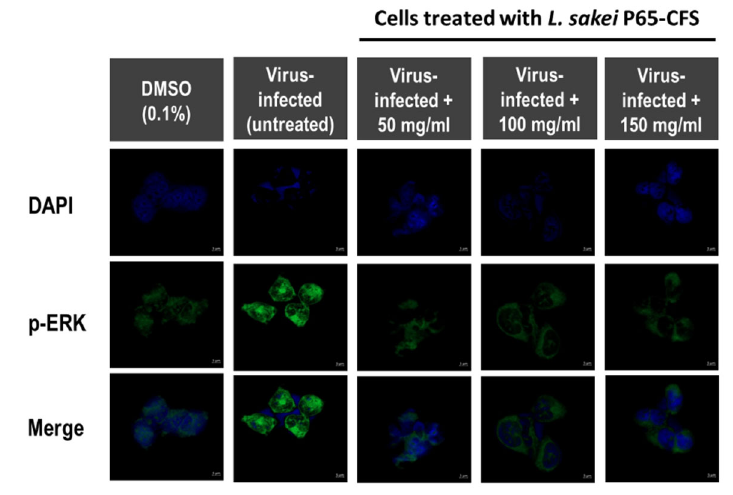
Figure 4. Expression of phosphorylated extracellular signal-regulated kinase (p-ERK) in HEK293 cells after infection with SARS-CoV-2 at MOI 0.1. During and after viral adsorption for 2 h, cells were treated with 50, 100, and 150 mg/mL of L. sakei Probio65 cell-free supernatant (P65-CFS). DMSO (0.1%) was used as positive control, while negative control cells were only treated with PBS. Cells were fixed 12 h after infection and double immunofluorescence staining was performed. The expression of p-ERK was visualized using confocal microscopy. Cell nuclei are stained blue, and p-ERK is stained green (scale bar = 5 µ